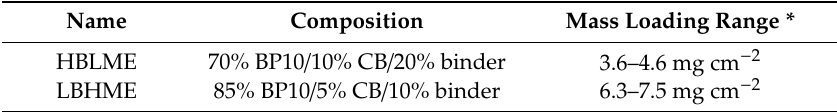
Table 1. Composition and mass loading of High Binder Low Mass Electrode (HBLME) and Low Binder High Mass Electrode